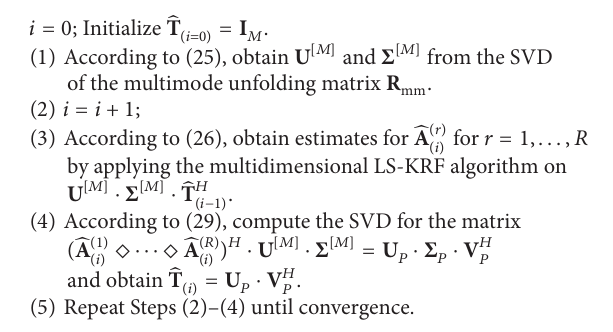
Algorithm 2: Summary of the ALS-ProKRaft algorithm.